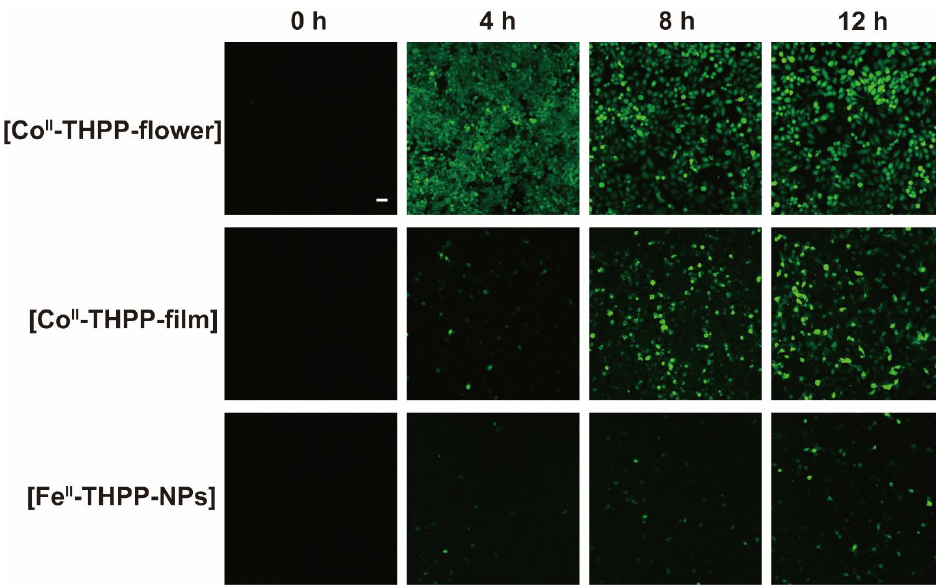
Figure 9. CLSM images of breast cancer cells 4T1 on treatment with [Fe II -THPP-NPs], [Co II -THPP- flower], and [Co II -THPP-film].